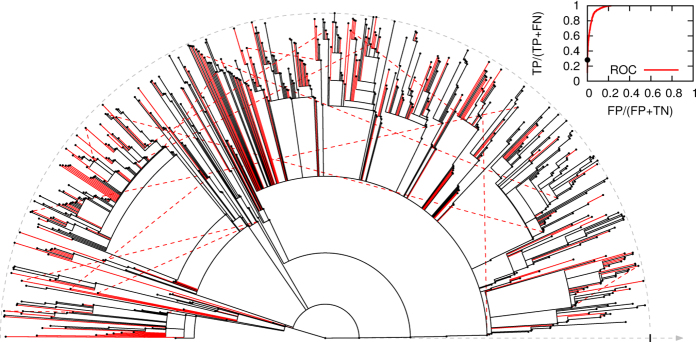
Reconstruction of the causal history of transmissions on a simulated epidemic outbreak on a sexual contact network infecting 719 individuals (black dots) from a snapshot of the infection state at time 2y (corresponding to the outer dashed semicircle).The figure represents the tree of transmissions in the outbreak originated in the central node (time flows in the outwards radial direction). Radial segments correspond to 718 true transmission events. The 4130 oriented pairs of infected individuals that were in contact were ordered by their decreasing estimated posterior probability of transmission. A ROC curve (area equal to 0.898) of the ordered list is shown in the top right panel, with the black point corresponding to the main figure. In the main figure, red full radial segments correspond to 202 correctly inferred transmissions (true positives, TP), black ones to non-inferred transmissions (false negatives, FN) and red dashed lines to the 16 wrongly predicted transmissions (false positives, FP).